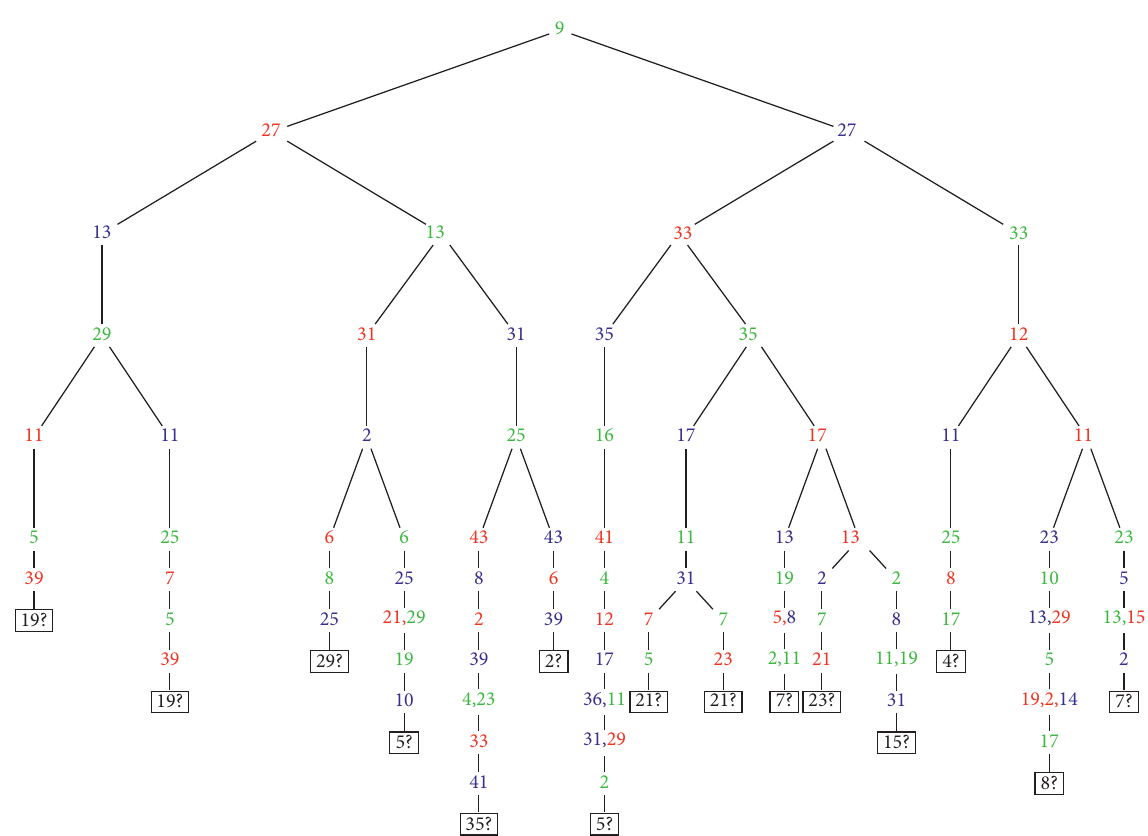
Figure 2: Tree representation for χ ( 9 ) �